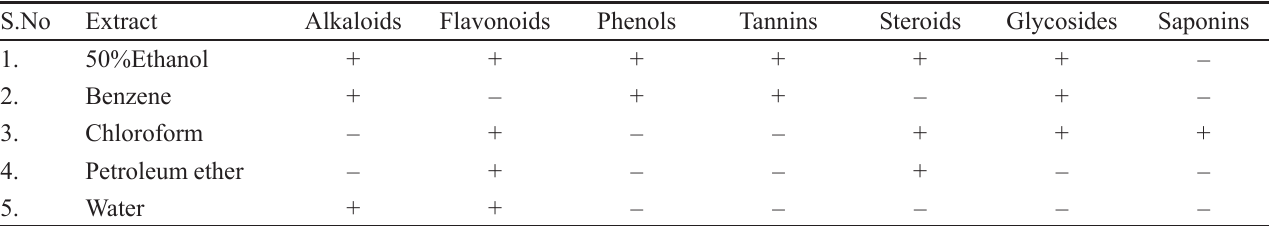
TABLE II - Phytochemical screening of pink Nelumbo nucifera flowers in different solvent extracts S.No